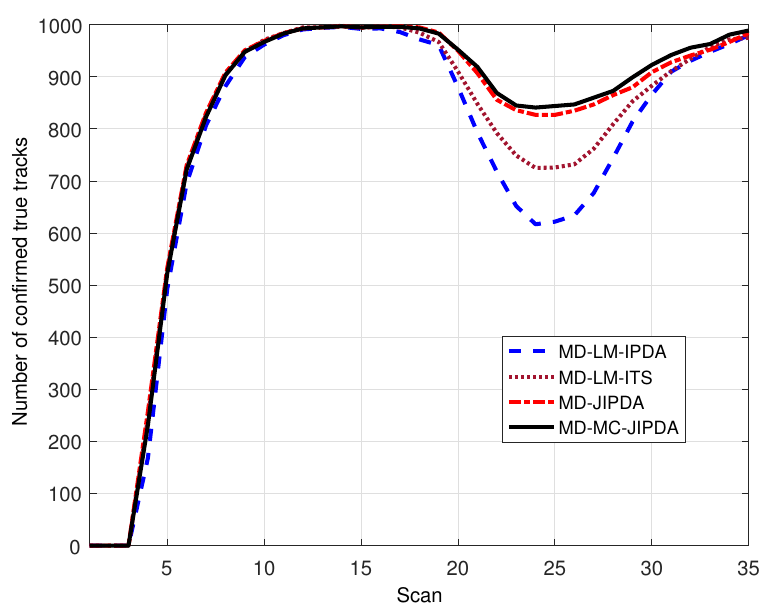
Figure 4. Number of confirmed true tracks for all targets.